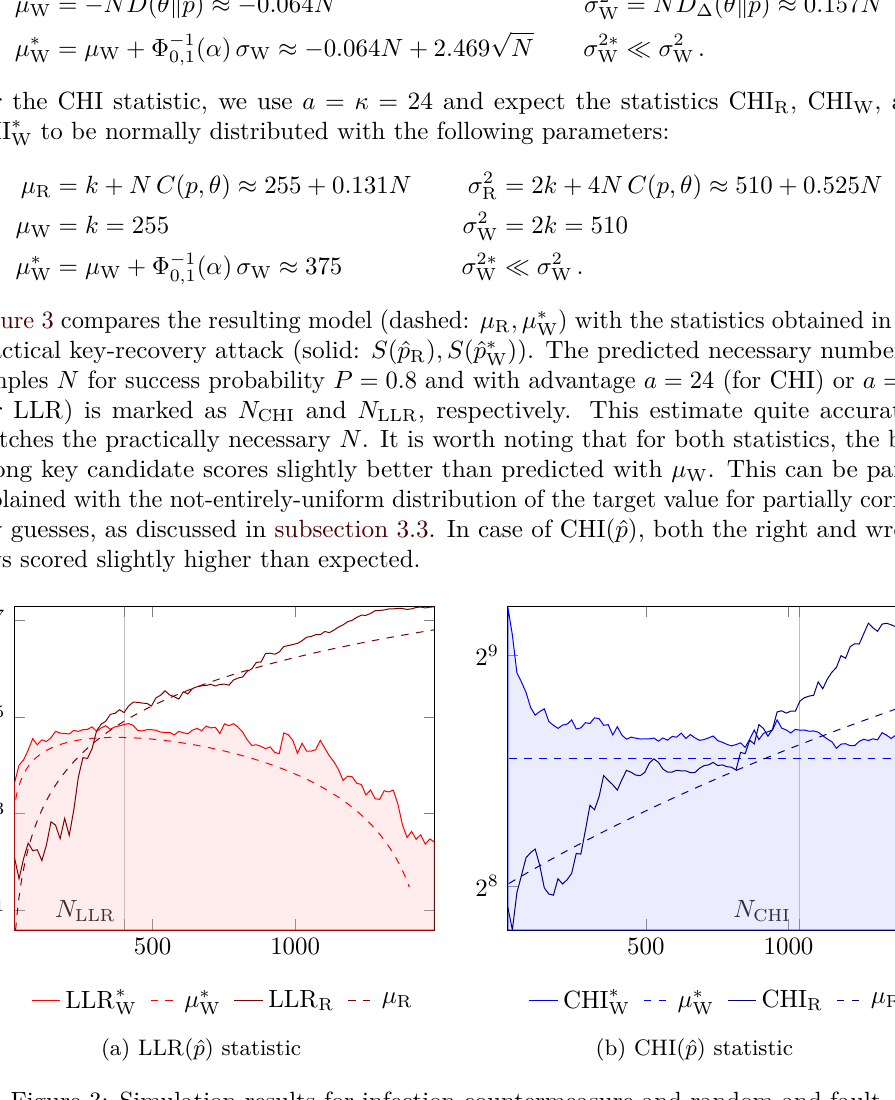
Figure 3: Simulation results for infection countermeasure and random-and